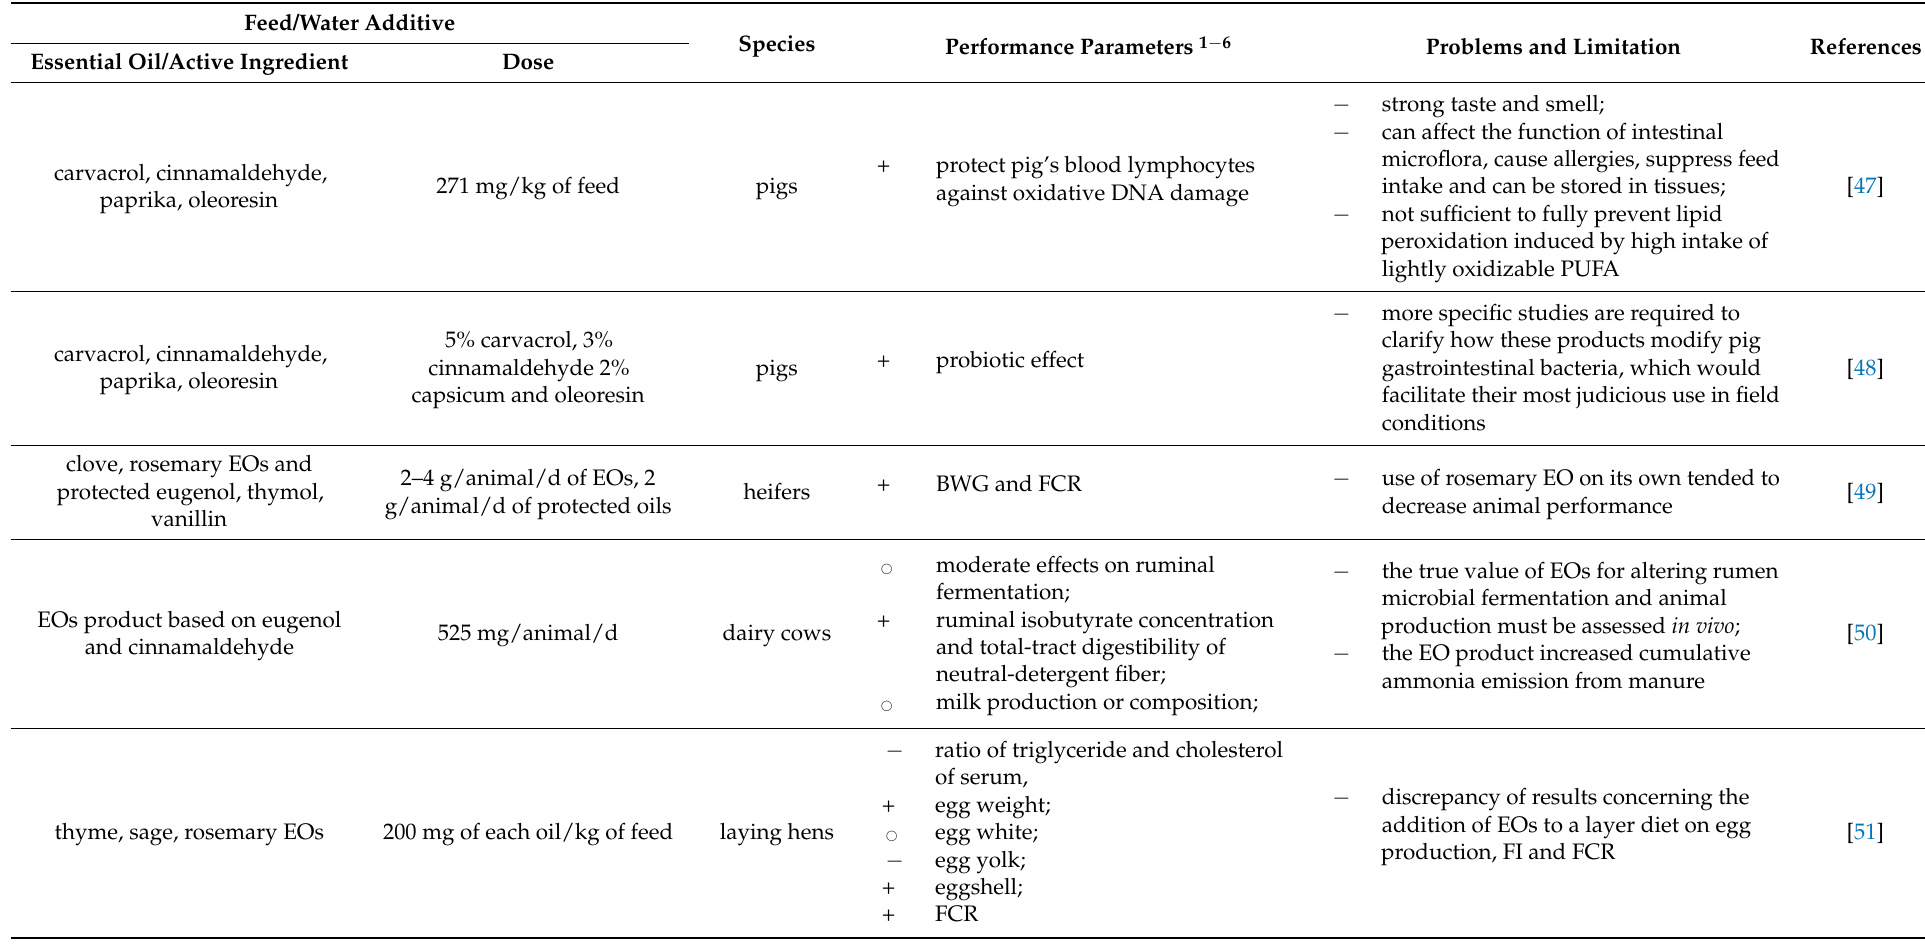
Table 4. The effect of essential oils (EOs) as functional feed ingredients on animal performance and product quality